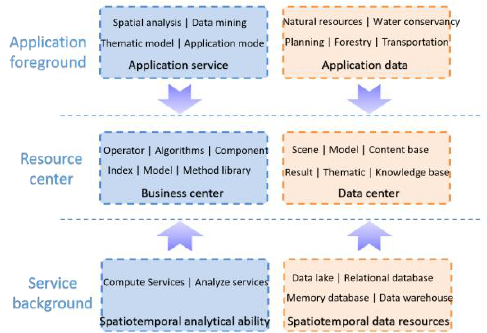
Figure 3. Shared service center in the platform